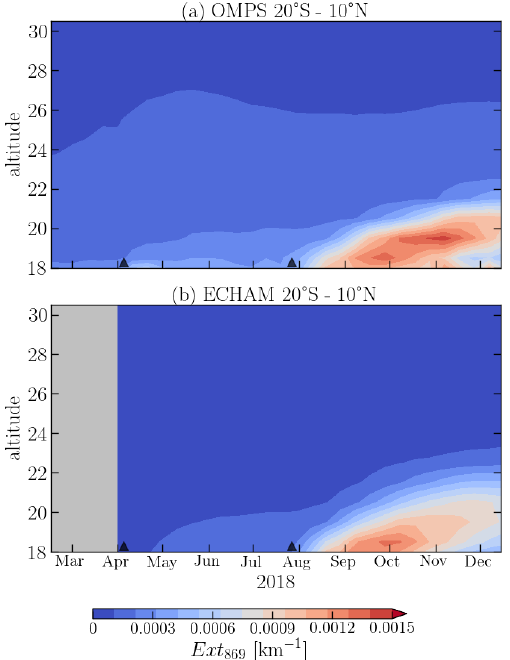
Figure 5. Evolution of zonal mean aerosol extinction coefficient ( Ext 869 ) in the Tropics (20 ◦ S–20 ◦ N), with altitude and time after the Ambae eruptions of 2018. In panel (a) , the data from OMPS-LP are presented, and in panel (b) the simulation with MAECHAM5- HAM is plotted. Both data sets were averaged over a 10d